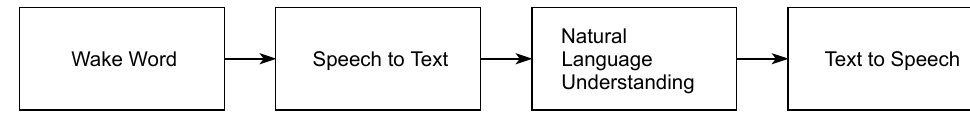
Figure 15. Common structure of speech